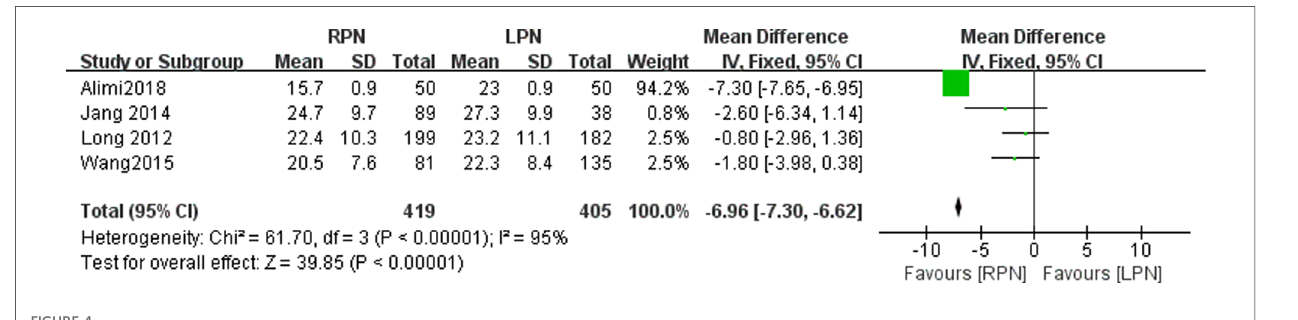
FIGURE 4 Forest plot for warm ischemia time between the RPN and